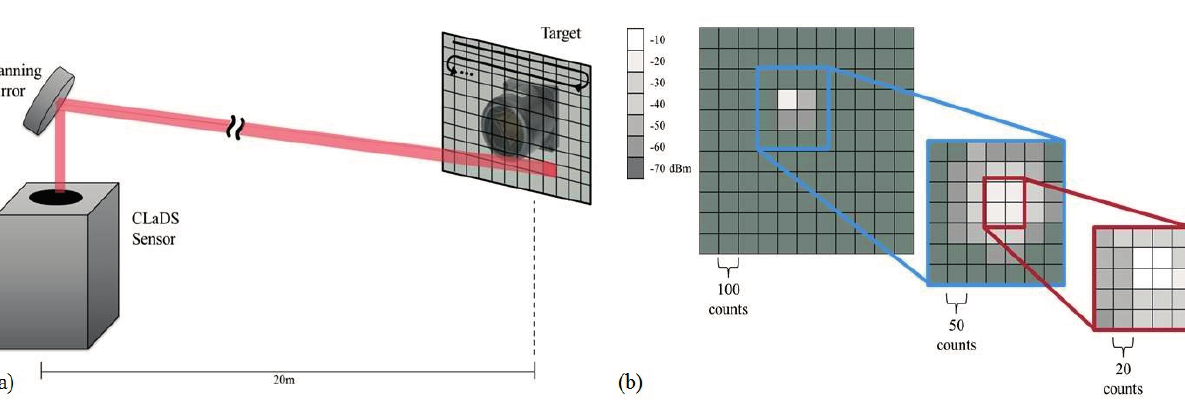
Figure 4. The sensor configuration deployed at SFES. The yellow rectangle, red circles, and the blue square represent the central sensor platform, the location of the six retro-reflectors, and the weather station, respectively. The image shows the mounting of the retro-reflector onto fence posts which were inserted several feet into the fen surface.